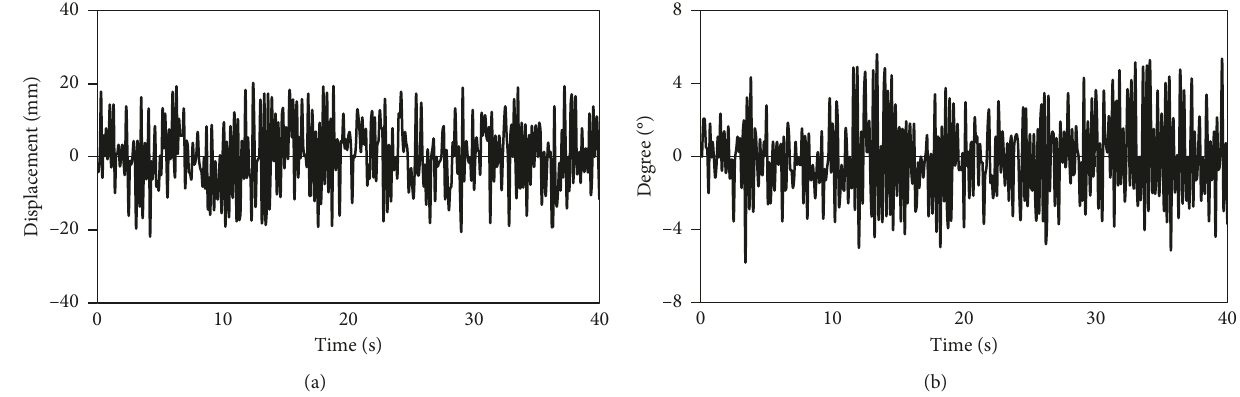
Figure 5: Time history responses for CM1, θ � 0 ° , 1.0(D), at 15m/s: (a) vertical vibration; (b) torsional vibration.